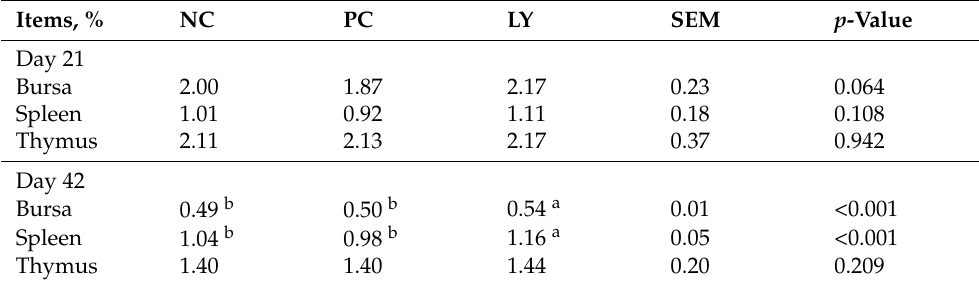
Table 6. Effect of dietary treatments on the immune organ index of broilers.